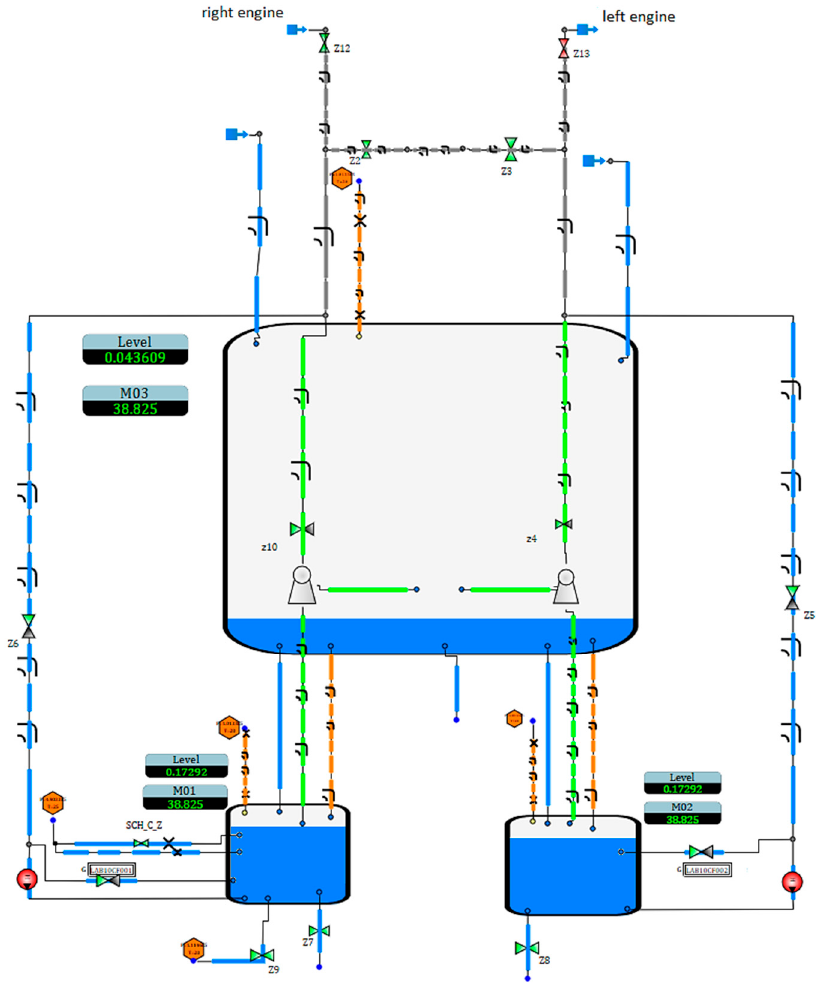
Figure 2. Structure of mathematical model, where: gray color—engine swap line; orange color—vent line; blue color—fuel supply line; green color—transfer line.